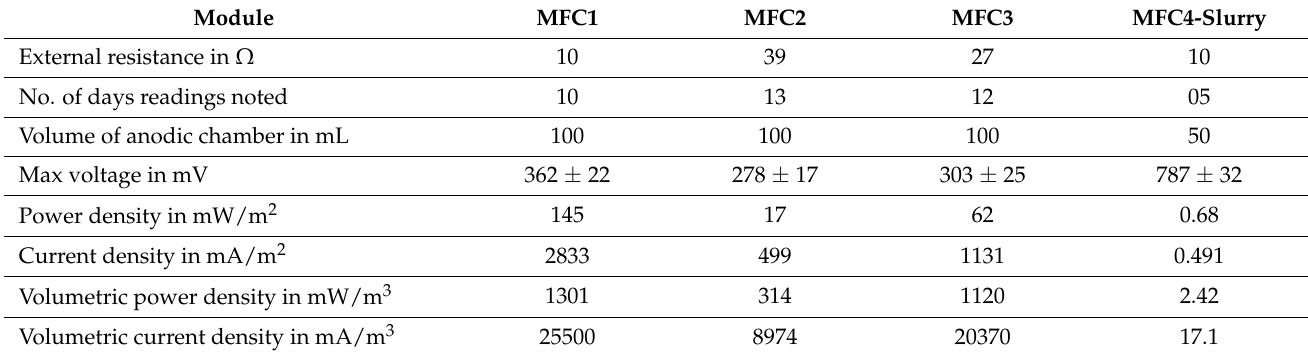
Table 2. Comparison table indicating maximum parameters by modules.